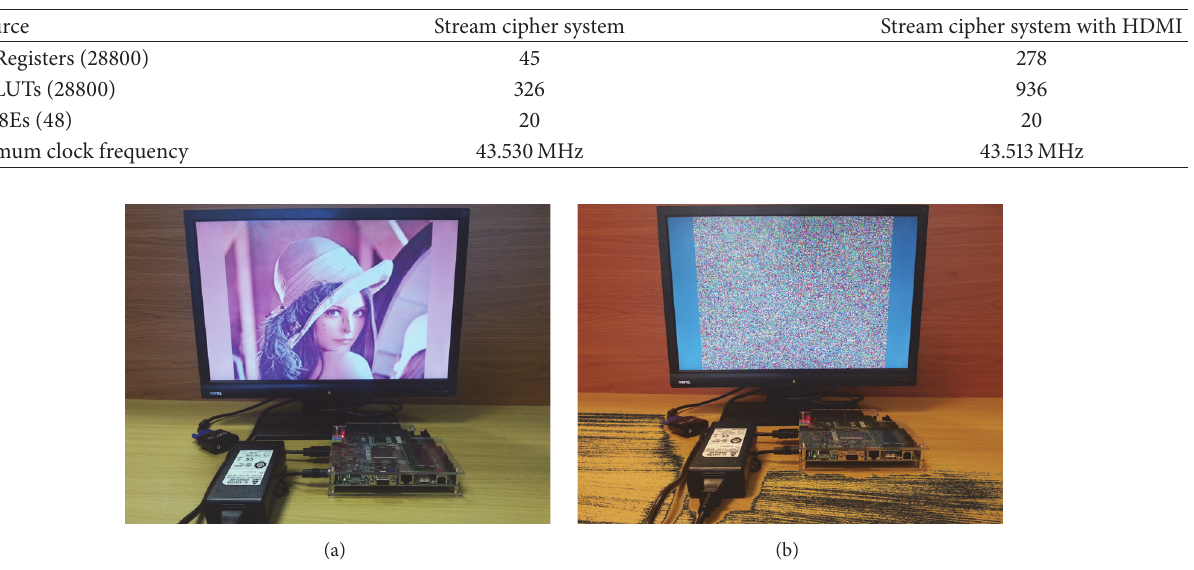
Table 6: Synthesis results of the 45-bit stream cipher system.